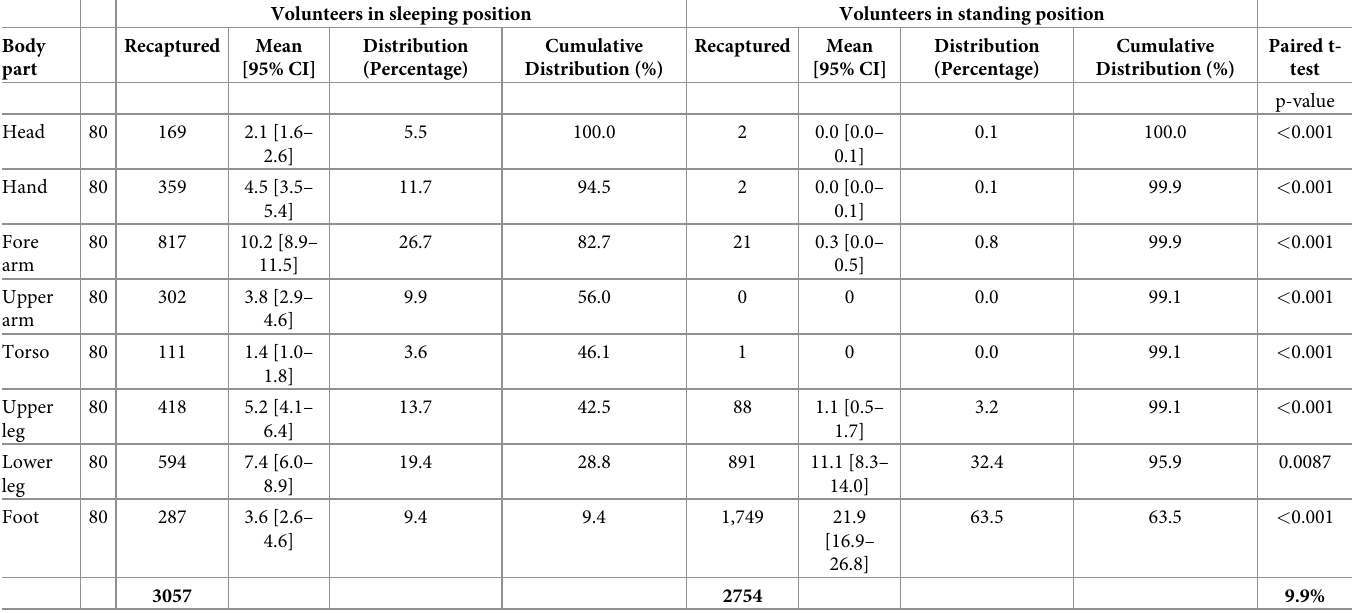
Table 2. Distribution of An . arabiensis landing sites on bodies of volunteers in sleeping and standing positions. Volunteers in sleeping position Volunteers in standing position Body